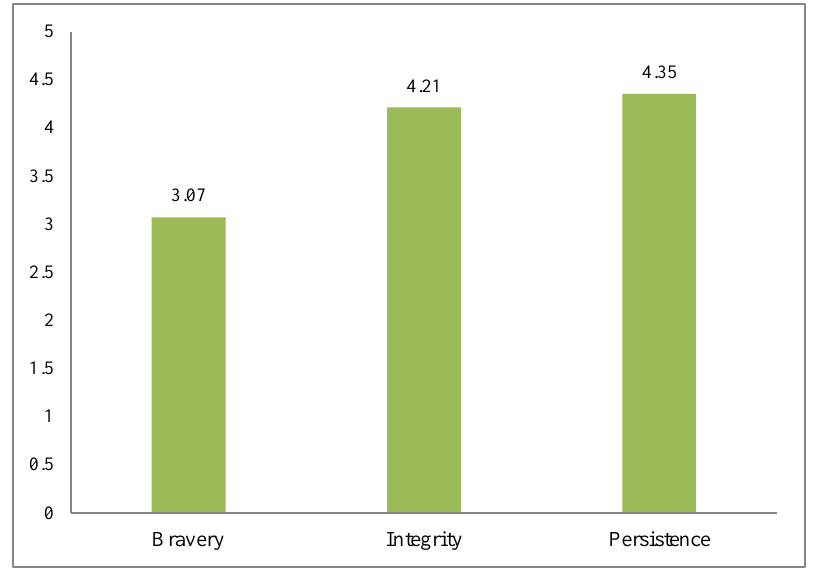
Fig. 3. 2nd virtue: Courage (means, rated on a 5-point scale,